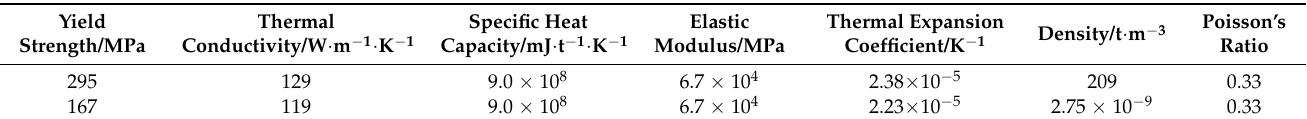
Table 2 . Material property of base metal and filler at 20 °C Table 2. Material property of base metal and filler at 20 ◦ C.